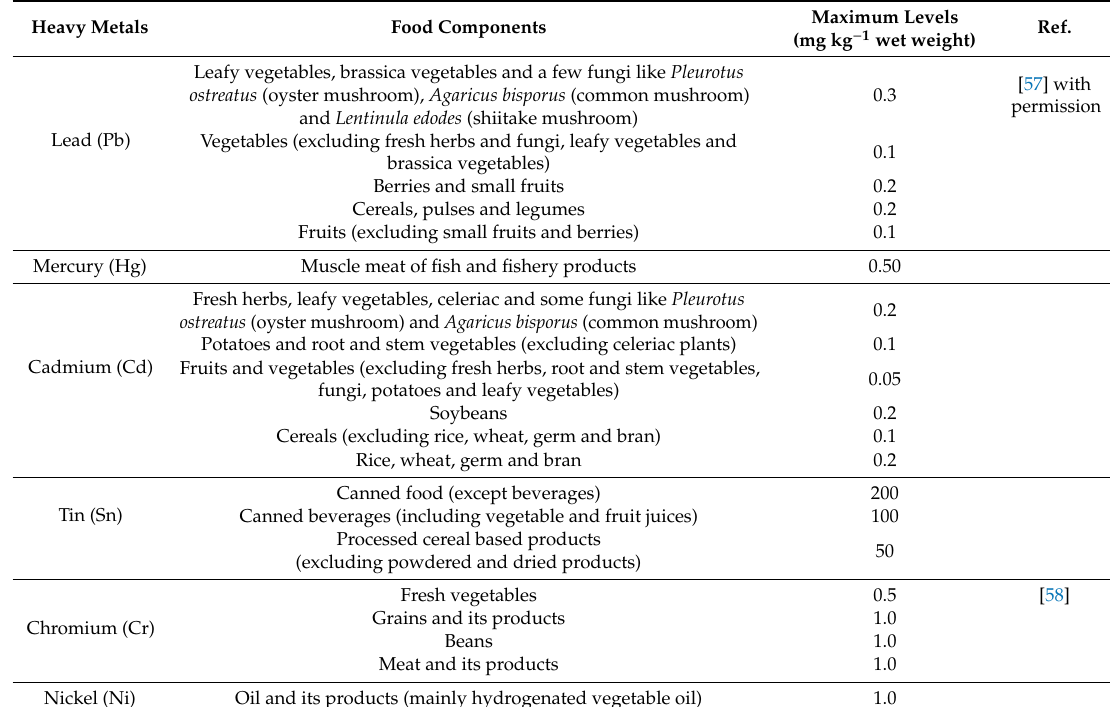
Table 2. Maximum level of heavy metals in food components (European Commission, 2006, 2015 / 1005, June 2015 and National Food Safety Standard (GB